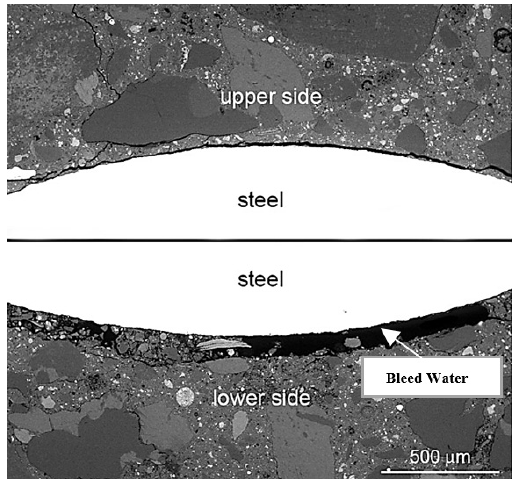
Figure 4. Zone of bleeding water under steel rebar, lower and upper SCI (PC: fly ash 20% w/b = 0.5) [23].